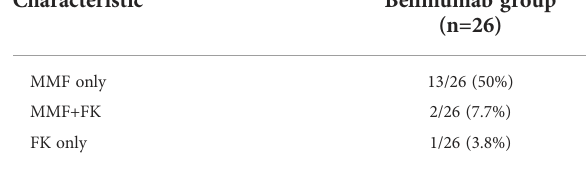
TABLE 1 The baseline demographic and clinical characteristics of 26 childhood-onset systemic lupus erythematosus